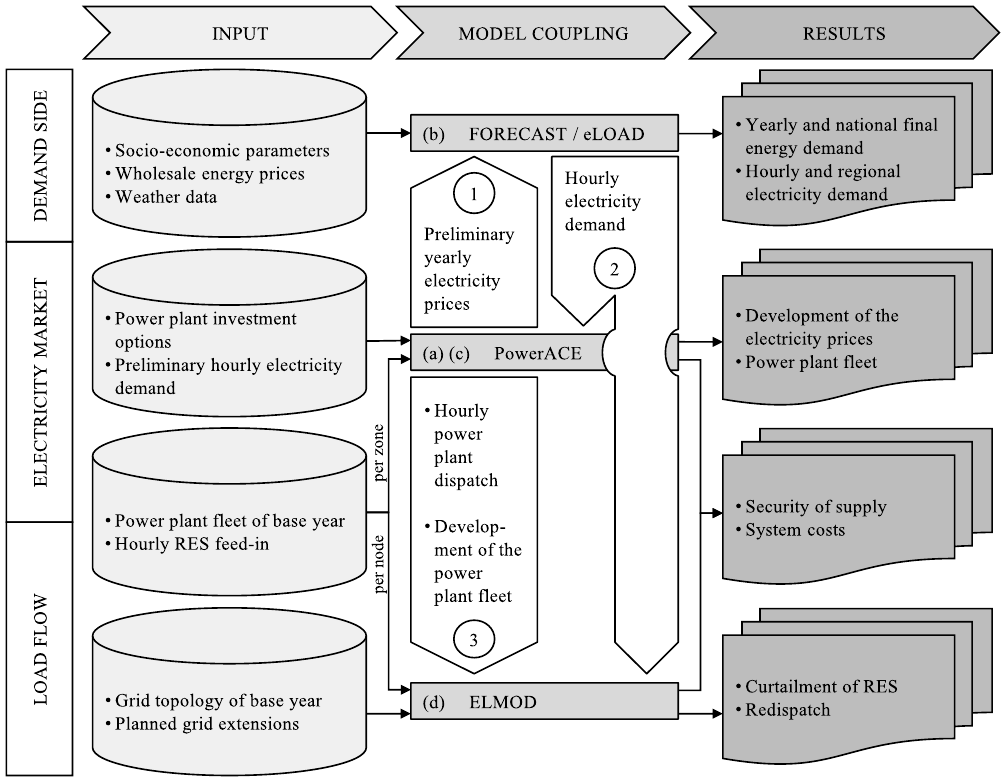
Figure 1. Coupling of the models FORECAST, eLOAD, PowerACE and ELMOD. Source: